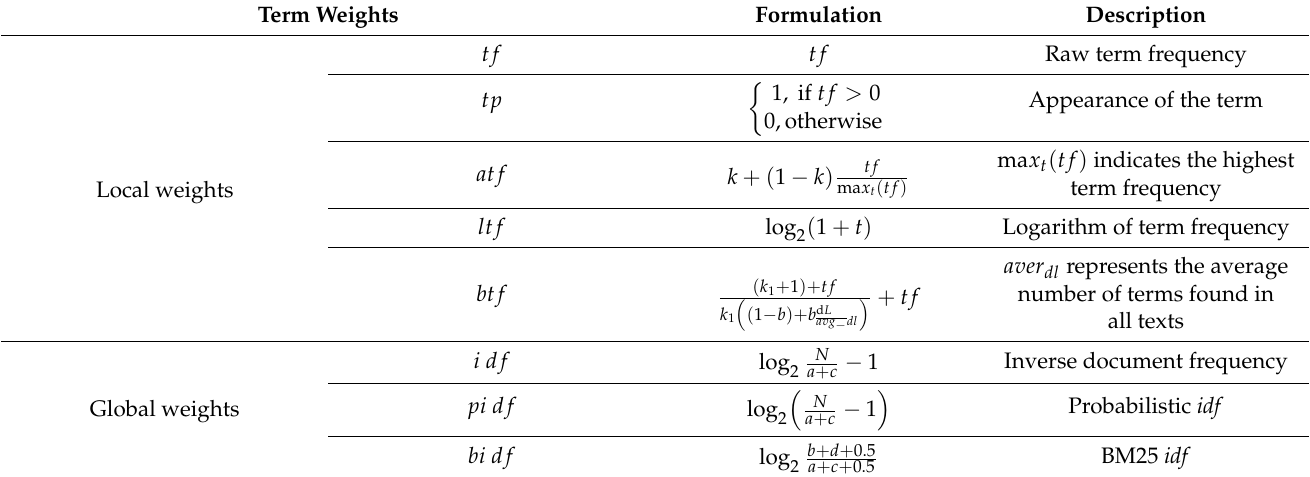
Table 1. Local and global term weighting